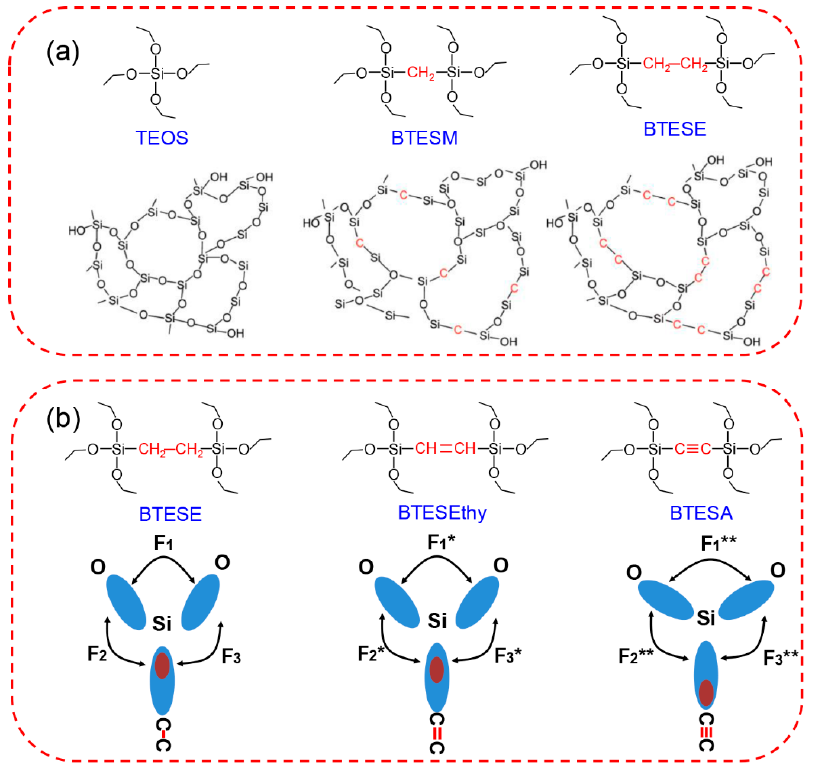
Figure 12. ( a ) Schematic illustration of amorphous network structures derived from tetraethoxysilane (TEOS), bis(triethoxysilyl)methane (BTESM), and bis(triethoxysilyl)ethane (BTESE) [89]. ( b ) Bonding structure model of BTESE-, BTESEthy-, and BTESA-derived networks [93].